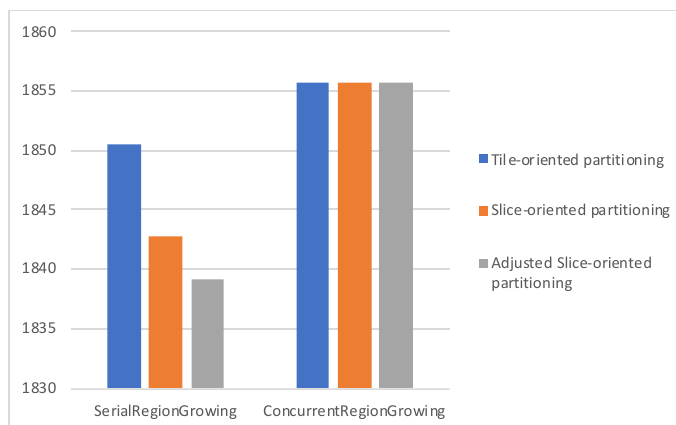
Figure 12. Average bitrate performance for 5 regions.